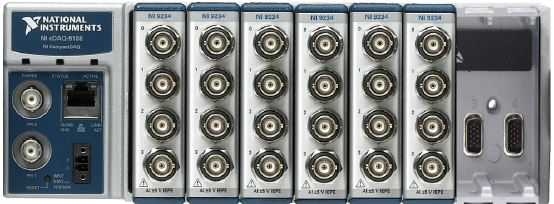
Figure 7. Data Acquisition System (DAQ) used in this work: cDAQ-9188 chassis and six NI-9234 modules from National